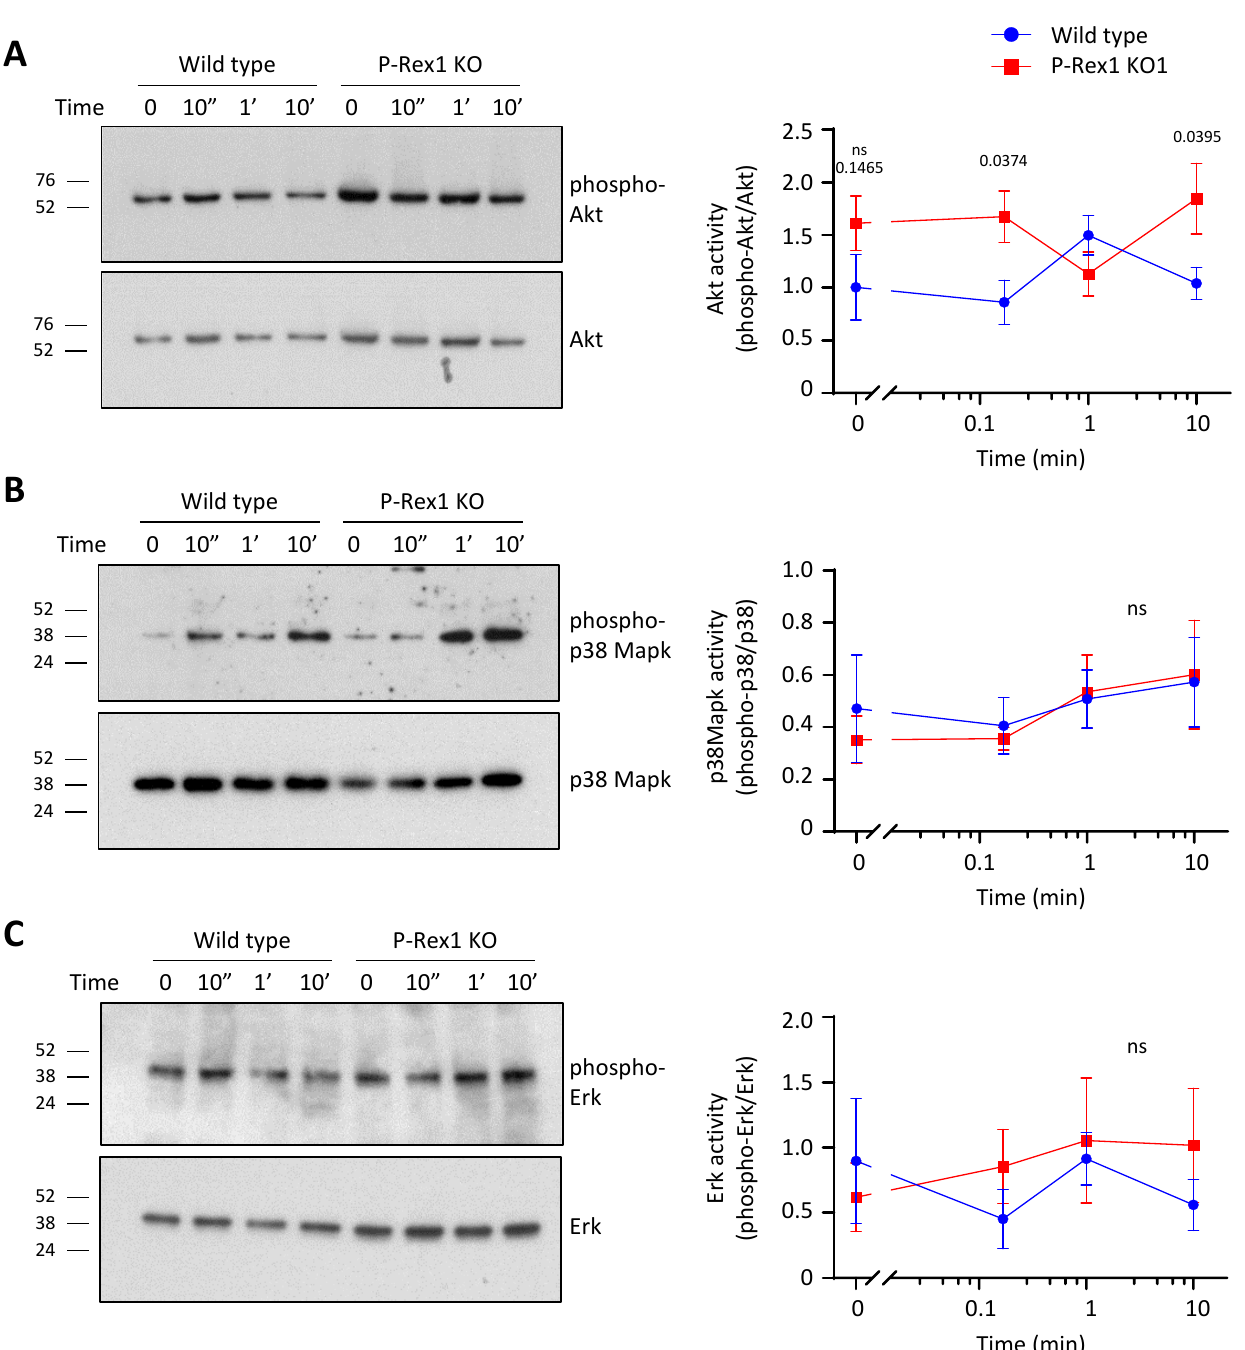
Figure 3. P-Rex1 deficiency increases Akt activity upon S1P stimulation without affecting p38 Mapk or Erk activities in PC12-S1PR1 cells. The same lysates of wild-type and P-Rex1-deficient PC12-S1PR1 cells as shown in Figure 2 were analysed for the activities of Akt, p38 Mapk, and Erk. ( A ) P-Rex1 deficiency increases Akt activity upon S1P stimulation of Figure 3: P-Rex1 deficiency increases Akt activity upon S1P stimulation, without affecting PC12-S1PR1 cells. Representative Western blots and quantification of Akt activity as phospho-Akt-S473 signal divided by p38 Mapk or Erk activity in S1P-stimulated PC12-S1PR cells total Akt signal are shown. ( B , C ) P-Rex1 deficiency does not affect p38 Mapk activity ( B ) or Erk activity ( C ) in S1P-stimulated PC12-S1PR1 cells. Representative Western blots and quantification of p38 Mapk activity, expressed as phospho-p38 signal divided by total p38 Mapk signal ( B ), and of Erk activity, expressed as phospho-Erk signal divided by total Erk signal ( C ), are shown. Data in ( A – C ) are from five independent experiments and are presented as the mean ± SEM. Statistical analysis involved two-way ANOVA with Sidak’s multiple comparisons test. ‘ns’ denotes data that were not significantly different between